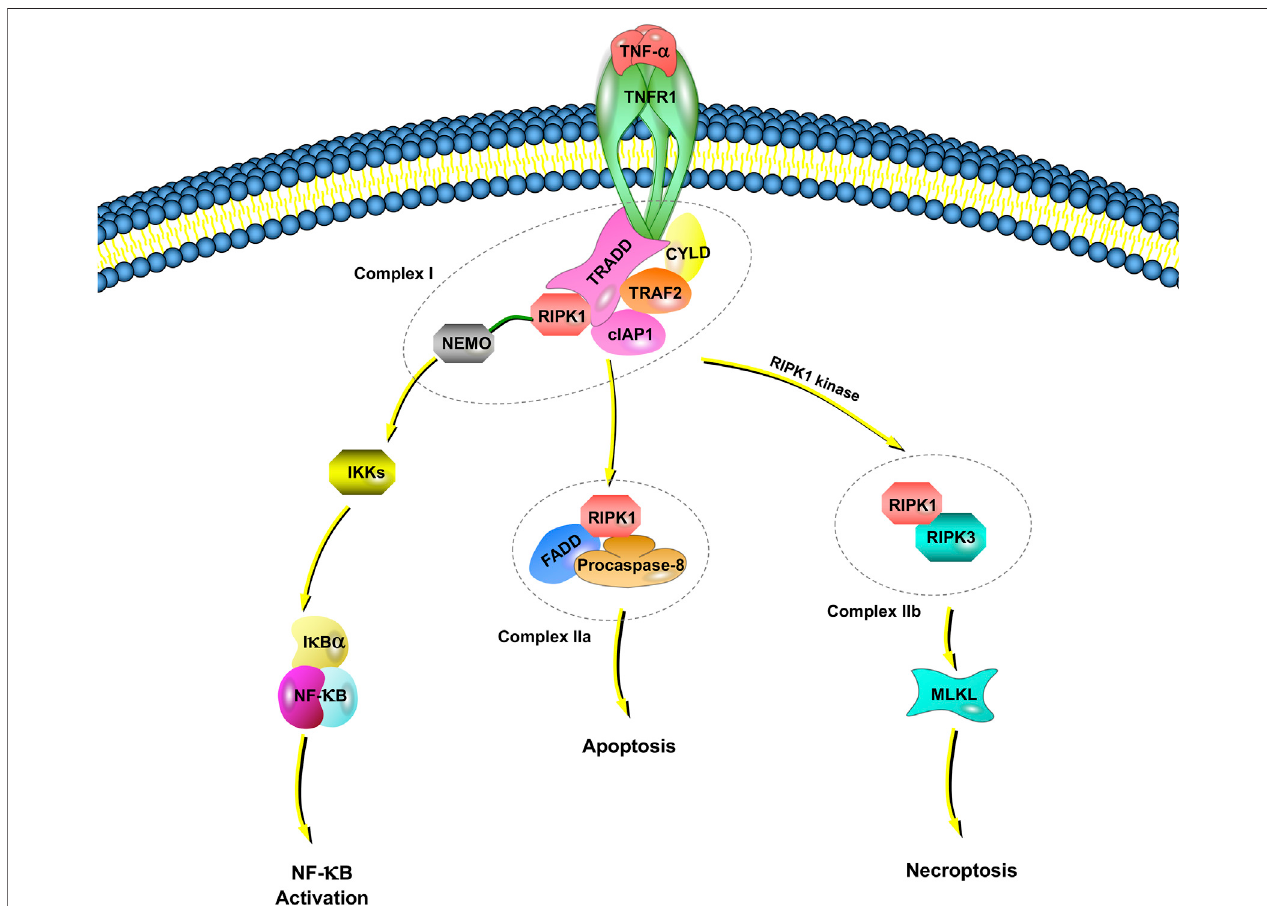
FIGURE 1 | TNFR1-dependent necroptosis pathways. TNF- ⍺ binds to TNFR1 and recruits a series of proteins, including TRADD, RIPK1, TRAF2, cIAP1, CYLD, and NEMO, which is called complex I. NEMO recruits IKK ⍺ /IKK β , resulting in the IKK-mediated phosphorylation of IkB ⍺ . Once IkB ⍺ is phosphorylated, NF-kB signaling pathways are activated. When NF- κ B activation is inhibited, deubiquitinated RIPK1, FADD and procaspase-8 are assembled as complex IIa. Complex IIa is involved in apoptosis by activated caspase-8 and cleavage RIPK1. When there is a lack of caspase-8, the cIAP1 in complex I rapidly ubiquitinates RIPK1, leading to the combination of RIPK1 and RIPK3, which is called complex IIb. Complex IIb leads to MLKL-mediated necroptosis.